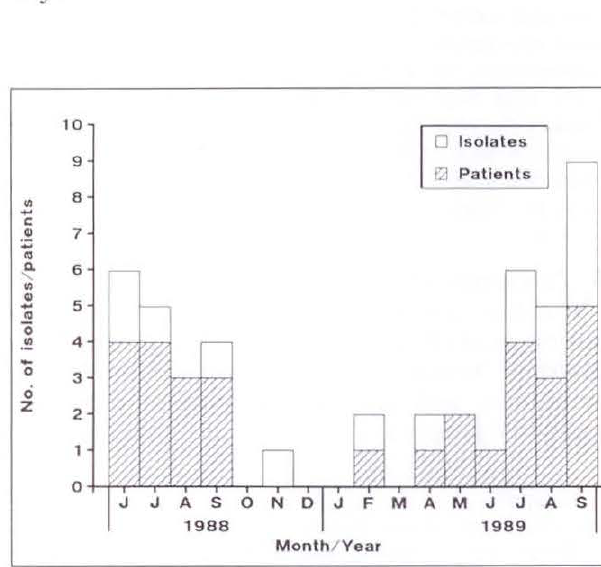
Figure 1) The distribution of uerocytotoxin-producing strains of Escherichia coli 015 7 by month from